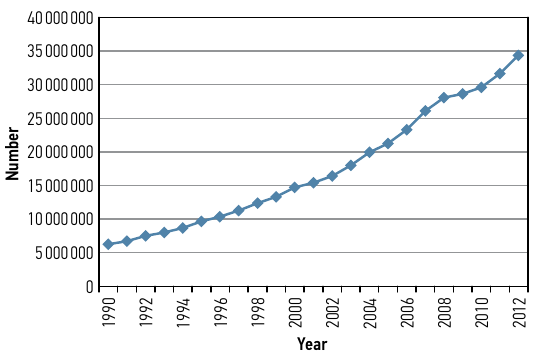
Fig. 1. End-year fleet size (data provided by the World Shipping Council – http://www.worldshipping.org